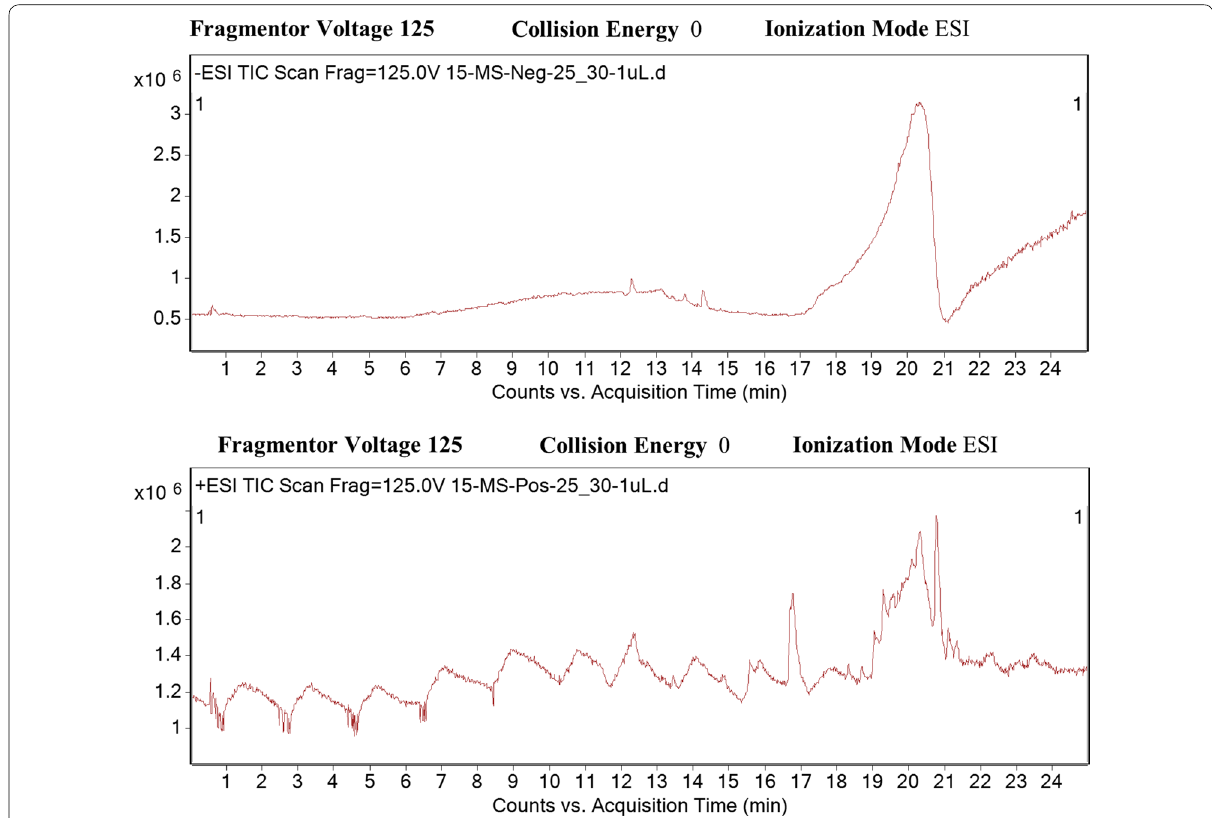
Fig. 4 Scolopendra subspinipes haemolymph was subjected to LC–MS (Agilent 6520 Accurate-Mass Q-TOF mass spectrometer with dual ESI source) for qualitative analyses. The compounds were separated based on m/z ratio and retention time in the column. The data obtained from the LC–MS for haemolymph contained numerous peaks, out of which 12 compounds have been detected with full identity and molecular structure, however, 36 compounds were detected with the limited information of only molecular mass and retention time in the